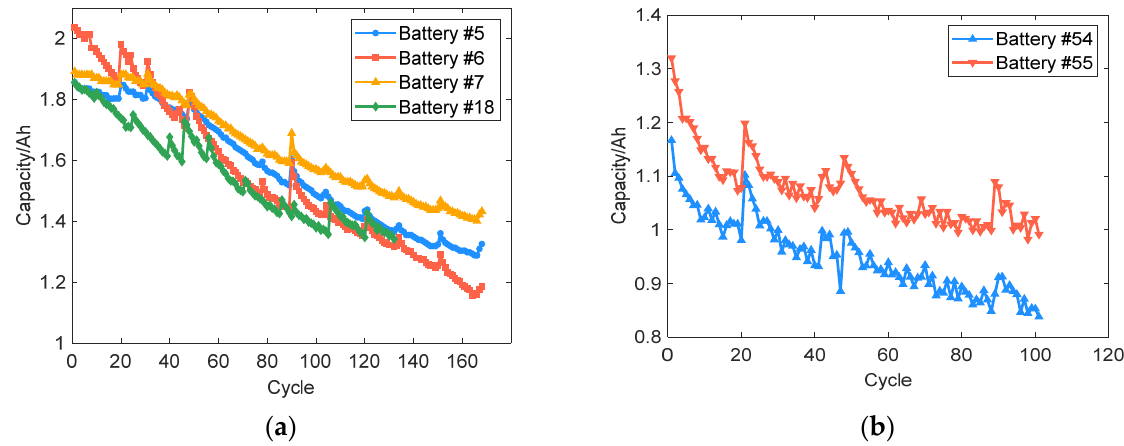
Figure 1. Capacity degradation curves of batteries. ( a ) #5, #6, #7, and #18; ( b ) #54, #55.